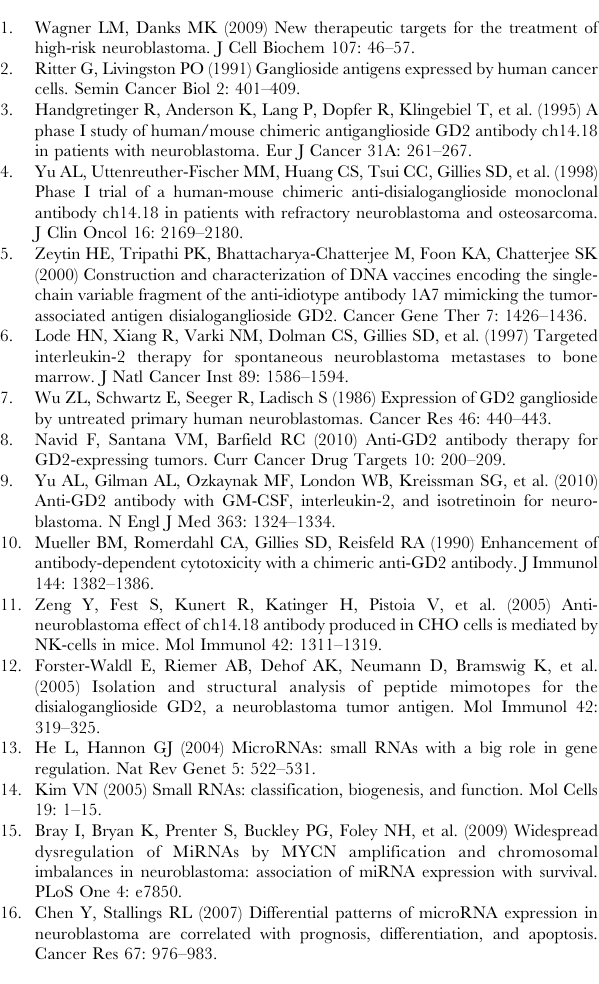
Figure S9 Association of low levels of TIMP2 mRNA with poor patient overall and event free survival. (TIF) Figure S10 (A) The sequence of both wild type and mutant 3 9 UTR for TIMP2 (B) TIMP2 3 9 UTR was PCR amplified from genomic DNA using flanking primers. (PDF) Table S1 Clinical and biological characteristics of neuroblastoma tumor